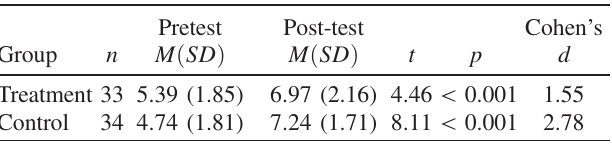
TABLE IV. Results of the paired-sample t tests for Integrated SPS Test.